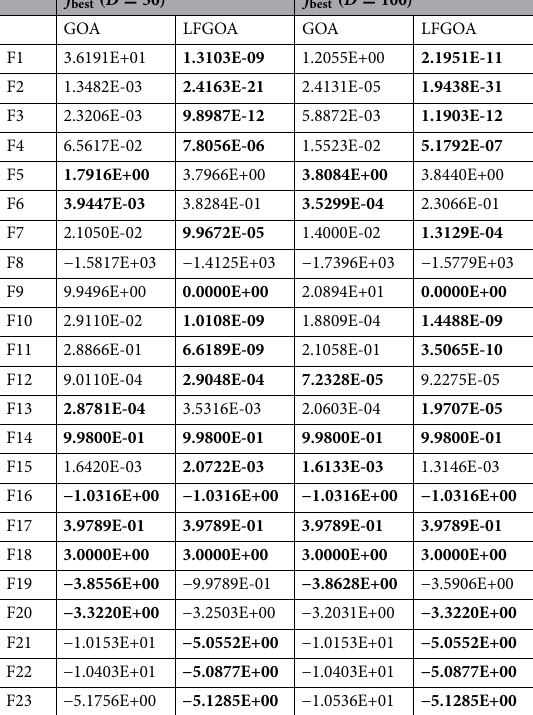
f best ( D = 50 ) f best ( D = 100